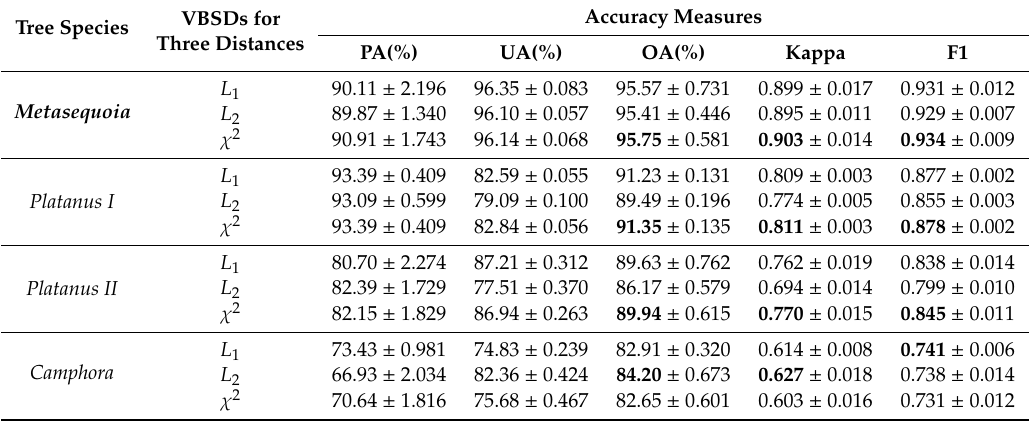
Table 3. Mapping accuracies of four tree species using the proposed method with VBSDs for three distances.